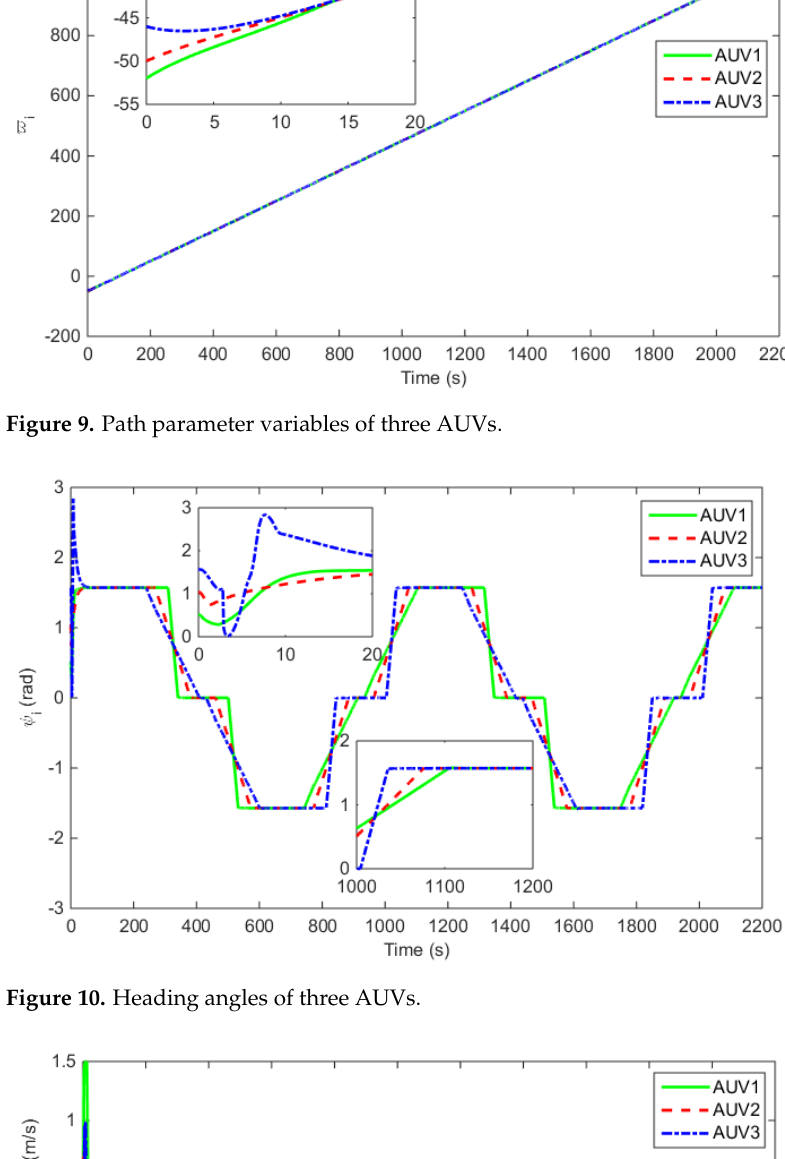
Figure 8. Cross-maneuvering errors of three AUVs.